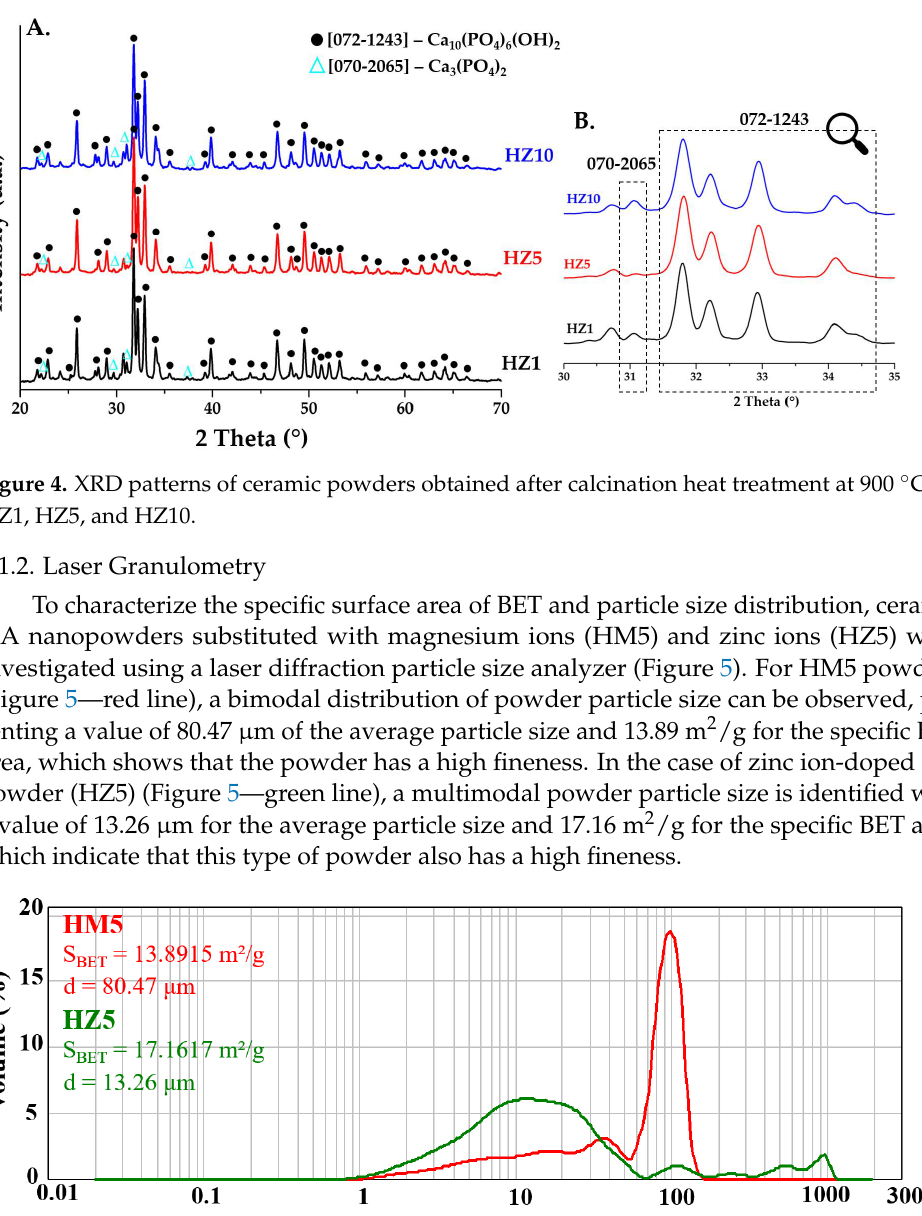
Figure 5. Granulometric distribution of ceramic powder. The red line indicates the magnesium ion doped HA (HM5) and the green line indicates the zinc ion doped HA (HZ5) .